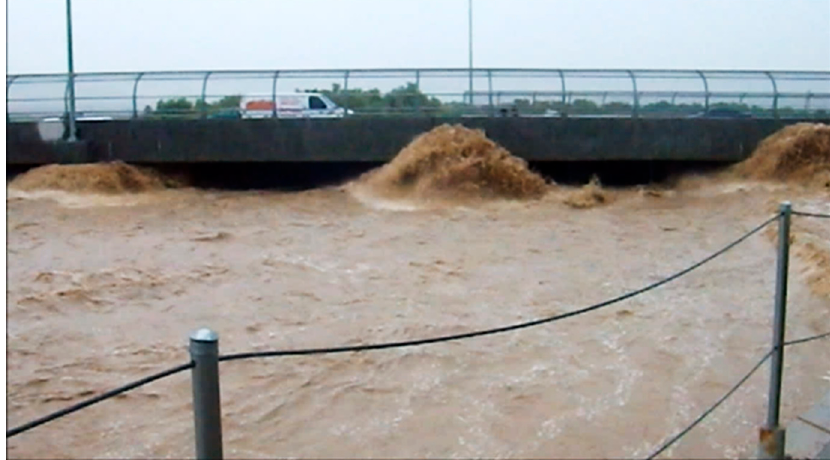
Figure 5. Duck Creek flood channel, Las Vegas metropolitan area. Table 2. Duck Creek Channel and bridge dimensions.